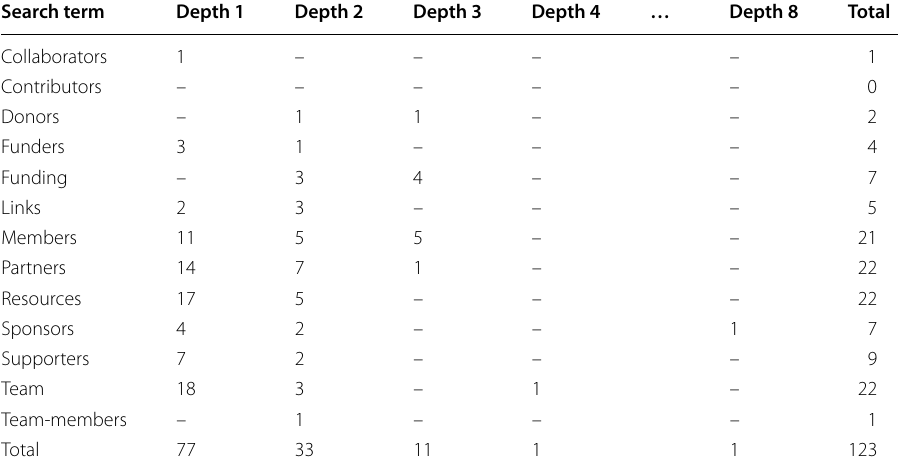
Table 2 Counts of the first occurrences of key words describing inter-organizational relationship in valid internal sub-page URL strings by